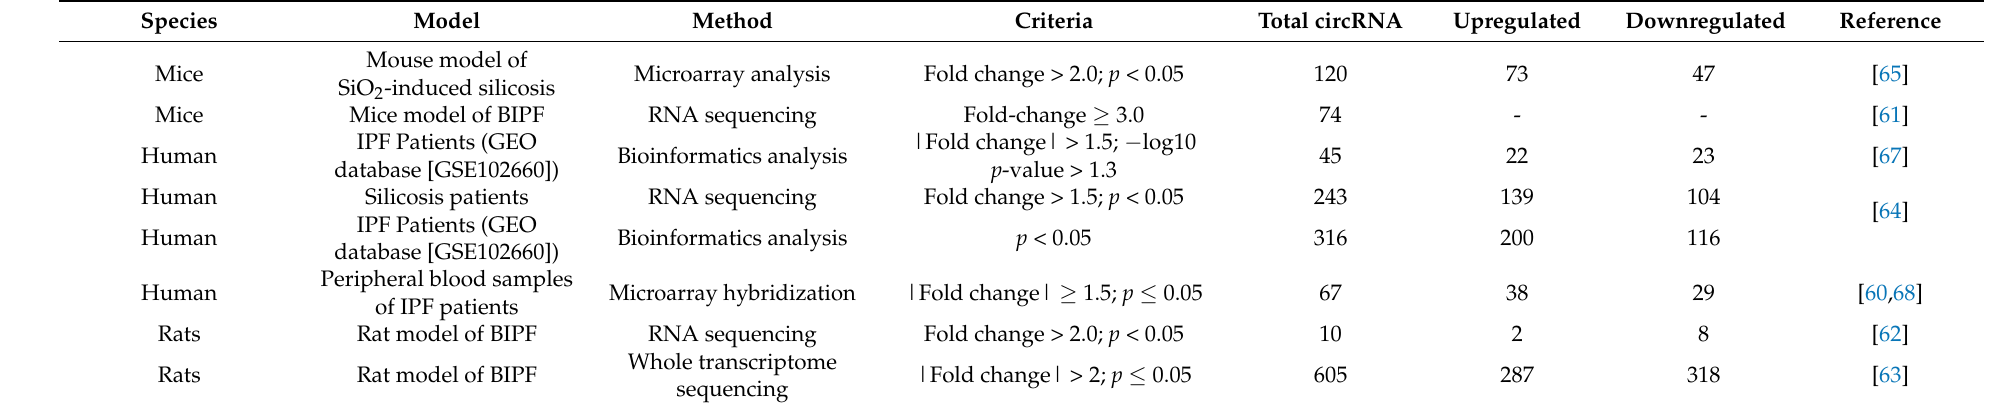
Table 1. circRNAs expression profiles in pulmonary fibrosis.